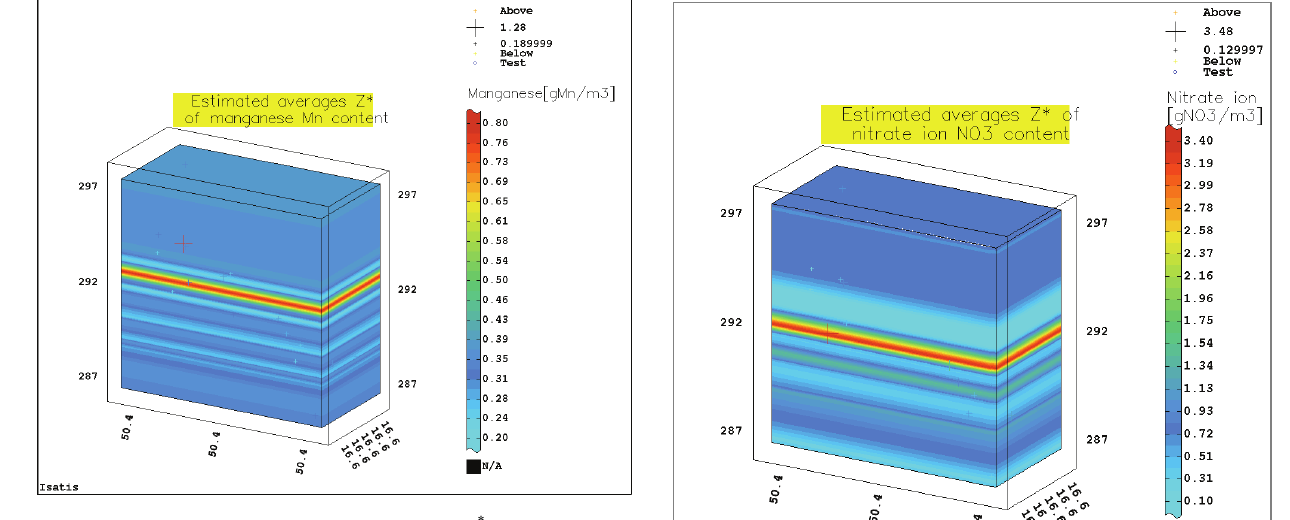
Fig. 24. Block diagram of estimated averages Z * distribution of manganese Mn ++ content [gMn ++ /m 3 ] in underground water in Kłodzko intake area; 14 wells + 3 piezometers